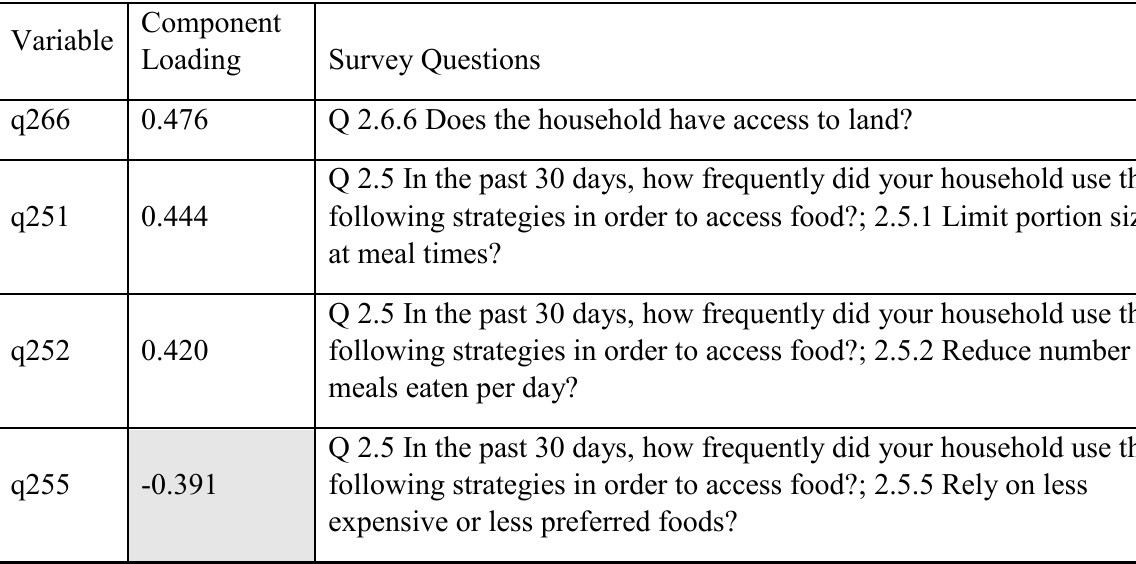
Table 1.12: Variables defining Absorptive Resilience PC6